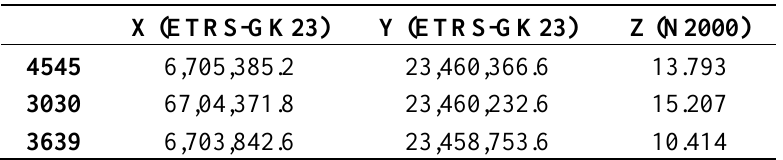
Table 3. Bedrock benchmark